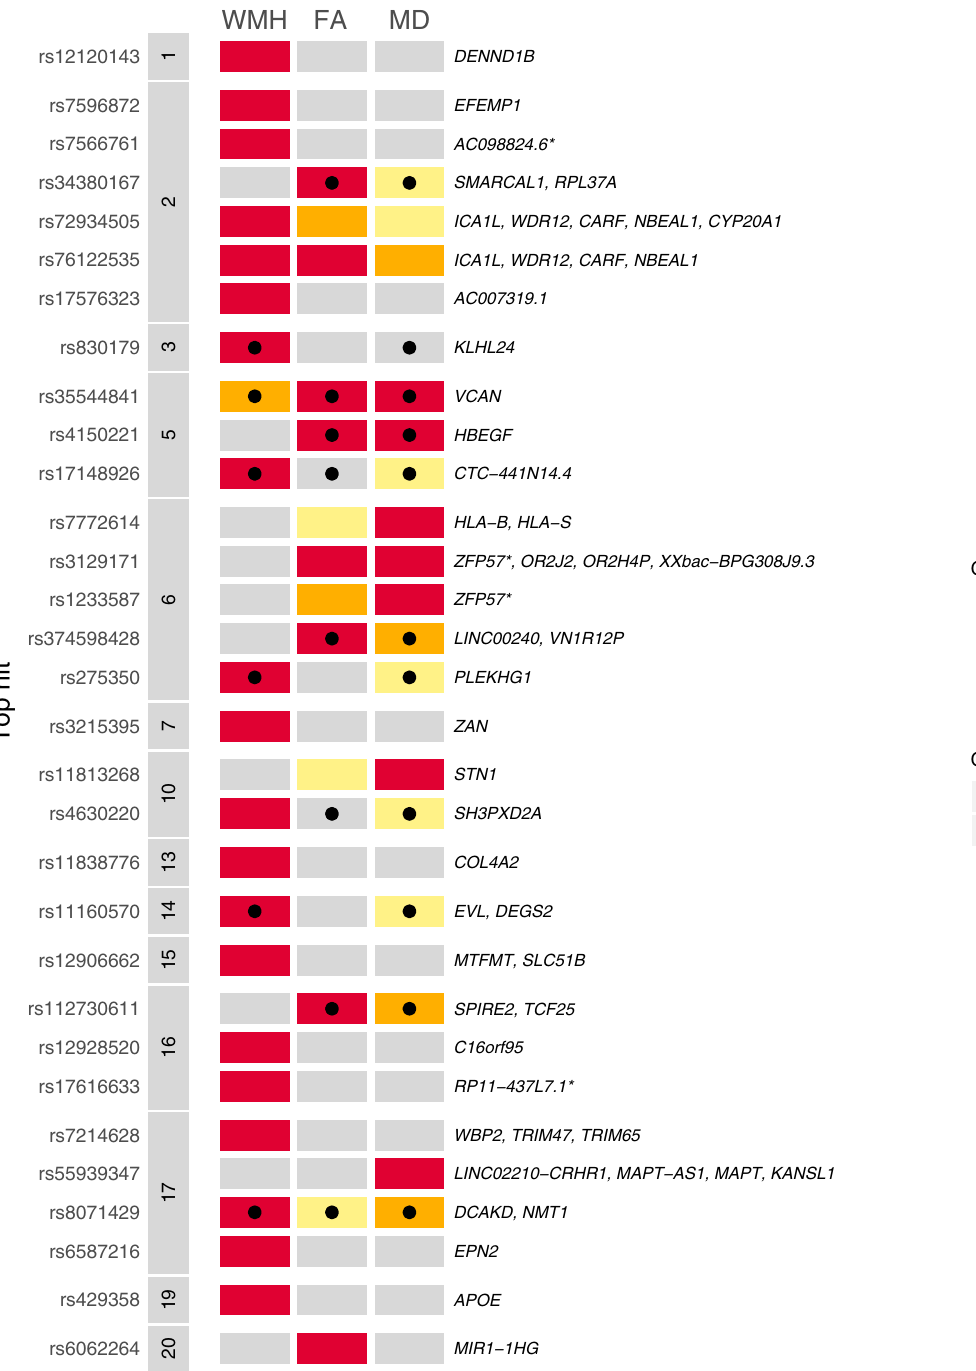
Fig. 2 Comparison of association signals across WMH, FA and MD. Gene annotation was perfomed with PhenoScanner. * The lead SNP and/or proxies lie in an intergenic region. PP is the posterior probability of